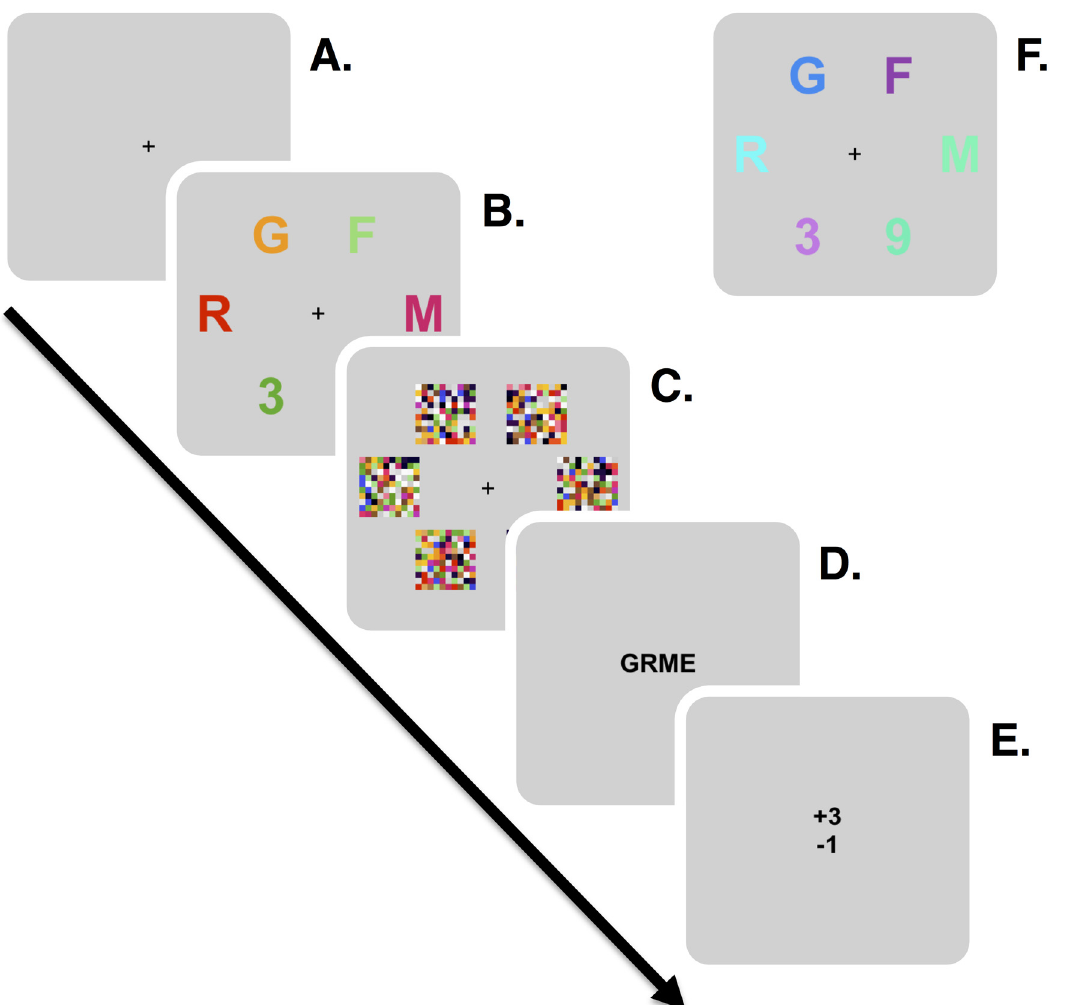
Fig 5. An illustration of the basic procedure in experiment 1. A. A fixation cross was presented until keystroke. B. Stimuli were presented for 10 – 150 ms. C. Stimuli were masked by pattern masks for 500 ms. D. Masks disappeared and observers responded by pressing the appropriate keys on a keyboard. Their responses were echoed in the center of the screen. E. When an observer had reported all letters from memory they pressed “ Enter ” and received instant feedback about their performance. F. An example of an incongruently colored grapheme display in a 4 target and 2 distractor